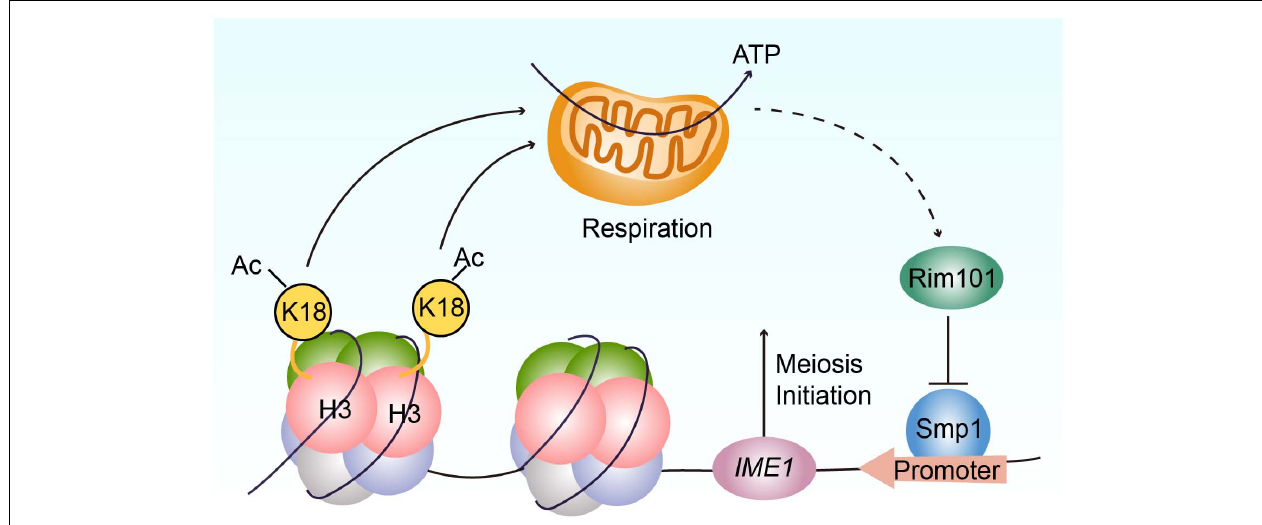
FIGURE 6 | Proposed model for the functional role of H3K18ac in meiosis initiation. H3K18ac influences the respiration to promote RIM101 expression that down-regulates SMP1 a repressor of IME1 transcription, induces IME1 expression, and finally leads to meiosis